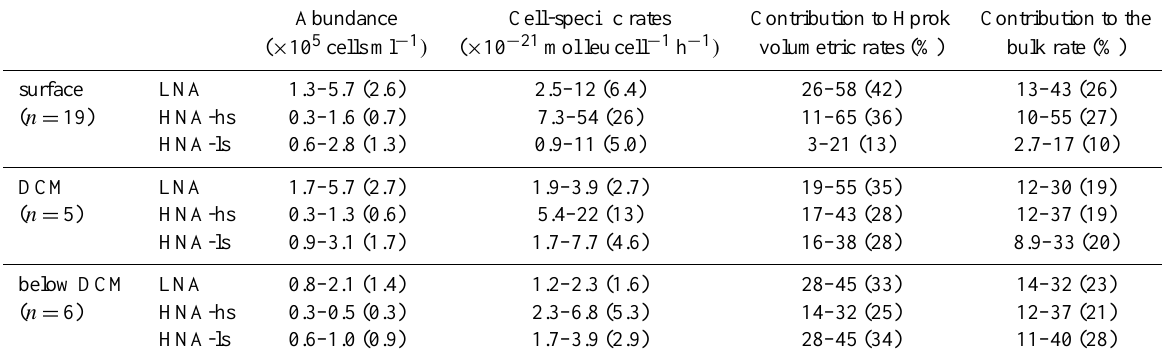
Table 2. Characteristics of the in situ Hprok cytometric groups (HNA-hs, HNA-ls and LNA): abundance, cell-specific leucine incorporation rates (cell-specific rates), contribution to Hprok volumetric rates (as the sum of HNA-hs, HNA-ls and LNA volumetric rates), and contribution to the bulk rate (whole sea water leucine incorporation rates). Data are presented as min – max (mean) values within 3 layers: “surface”: (between sea surface and the DCM depth), DCM (exact DCM depth) and “below DCM” (between DCM and the maximum layer